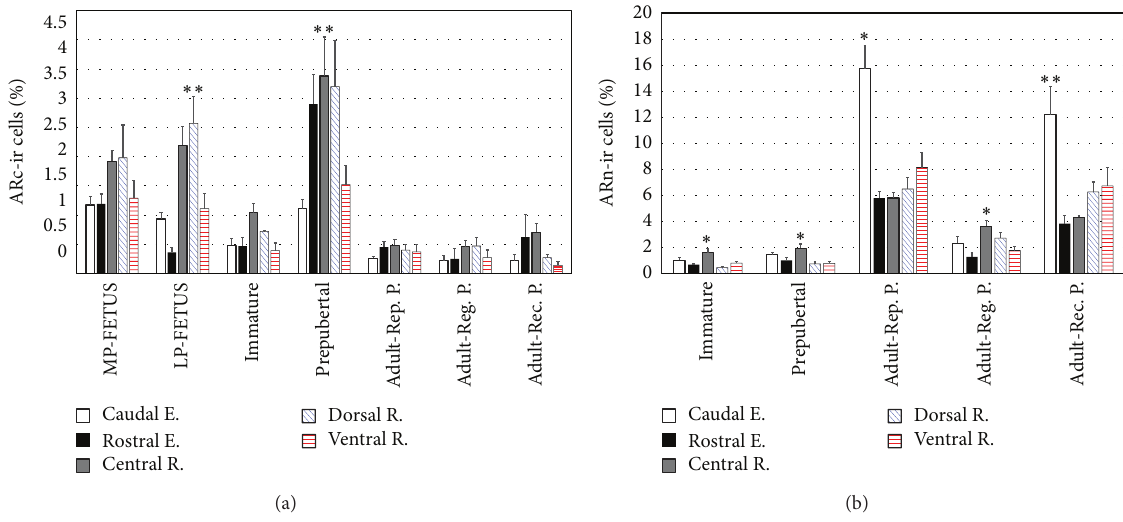
Figure 2: Morphometry of AR-ir cells in pituitary of male viscacha in different pituitary PD zones. (a) % ARc-ir cells. LP-FETUS: ∗∗ 𝑃 < 0.01 dorsal R. versus ventral R., rostral E., and caudal E. Prepubertal: ∗∗ 𝑃 < 0.01 medial R. versus ventral R. and caudal E. Adults: the percentage of ARc-ir cells did not reveal statistically significant changes in PD zones. (b) % ARn-ir cells. Immature: ∗ 𝑃 < 0.05 medial R. versus dorsal R. and rostral E. Prepubertal: ∗ 𝑃 < 0.05 medial R. versus dorsal R. and ventral R. Adult-Rep. P.: ∗ 𝑃 < 0.05 caudal E. versus the other PD zones. Adult-Reg. P.: ∗ 𝑃 < 0.05 medial R. versus ventral R. and rostral E. Adult-Rec. P.: ∗∗ 𝑃 < 0.01 caudal E. versus rostral E. and medial R. Fetuses from midpregnancy, MP-FETUS; fetuses from late pregnancy, LP-FETUS; reproductive period, Rep. P.; gonadal regression period, Reg. P.; gonadal recovery period, Rec. P.; region, R.; end,